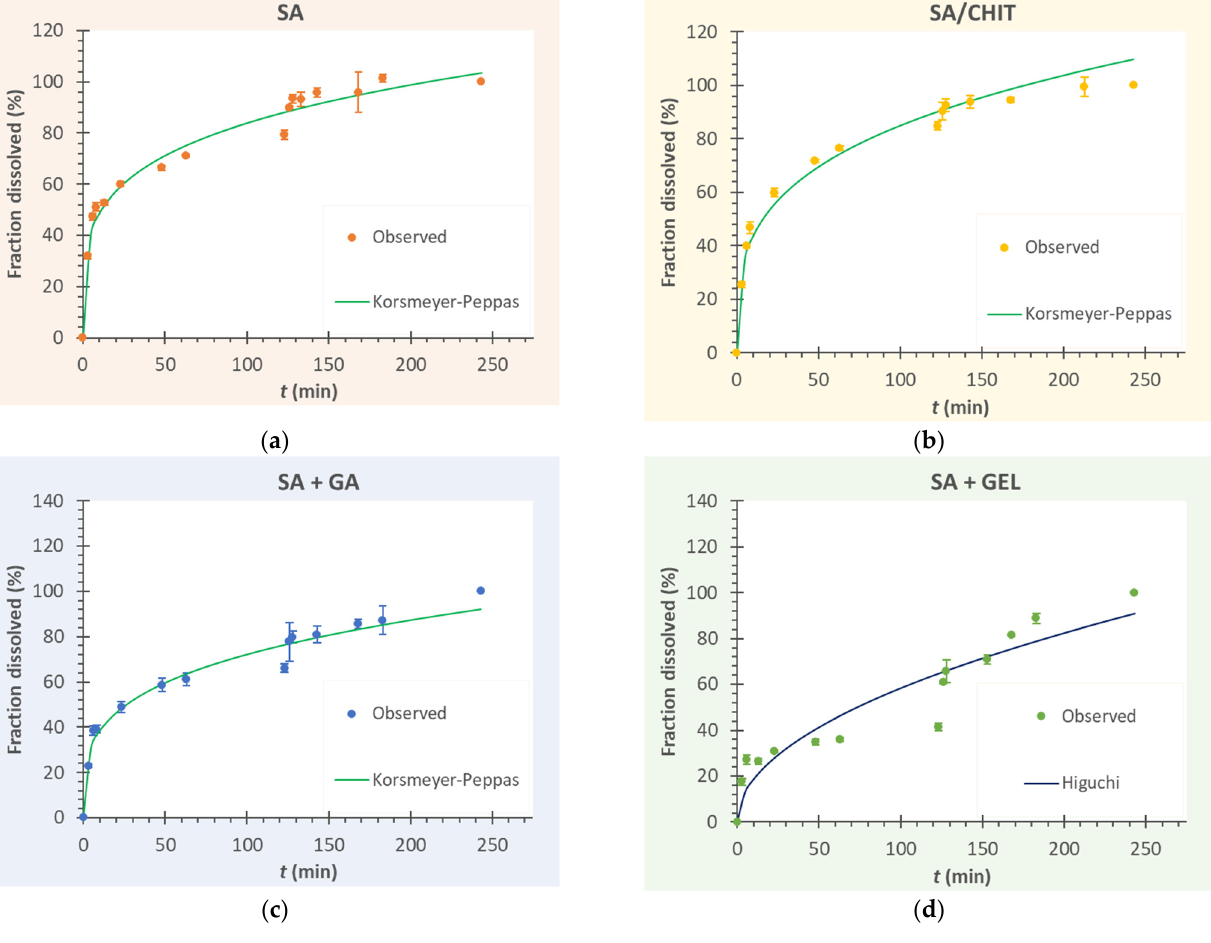
Figure 7. Kinetics of phenolic compound release from freeze-dried microbeads containing grape pomace extracts prepared with ( a ) sodium alginate (SA); ( b ) sodium alginate with chitosan (SA/CHIT); ( c ) sodium alginate with gum arabic (SA + GA); and ( d ) sodium alginate with gelatin (SA + GEL) (symbols—experimental data, lines—approximate curves, according to the most suitable model).